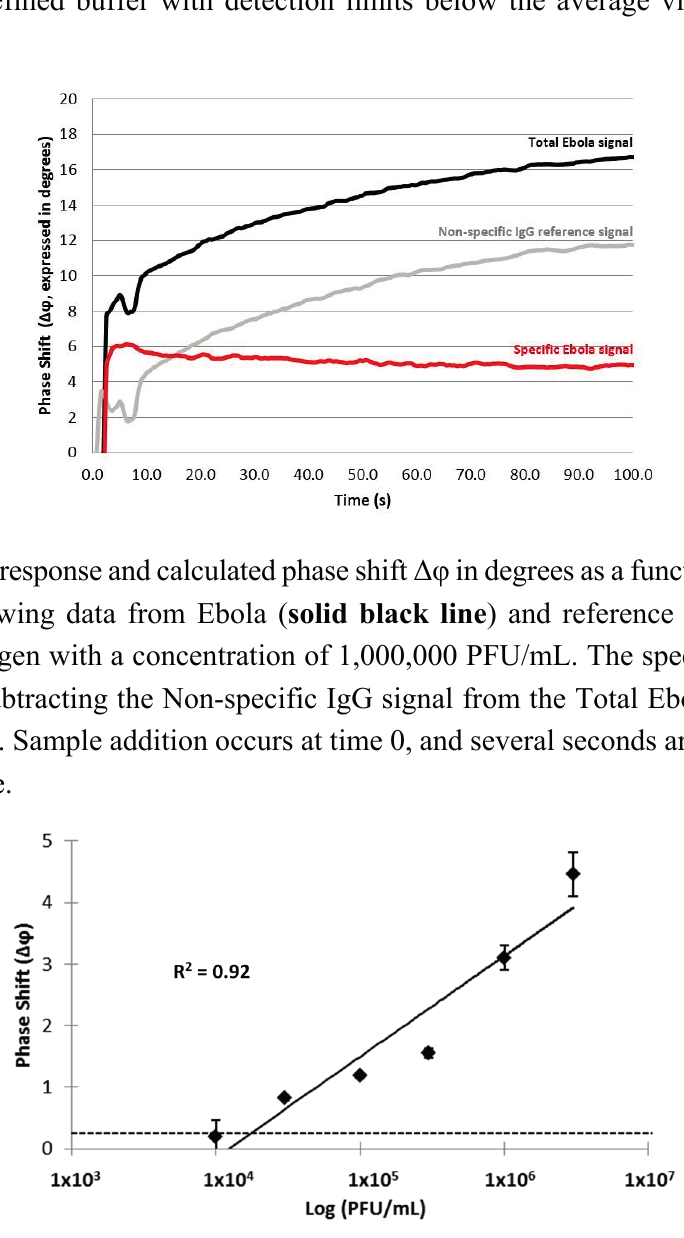
Figure 4. Detection of Ebola-Zaire with a SAW biosensor functionalized with an anti-Ebola monoclonal antibody. Triplicate measurements (mean ± standard deviation) were taken at 5 min after addition of the virus. Standard deviations for three of the data points are smaller than the corresponding size of the data marker. The x-axis and y-axis indicate viral load (logarithmic scale; PFU/mL) and phase shifts ( Δφ , expressed in degrees), respectively. Concentrations of Ebola antigen corresponding to PFU of intact virus were established in a defined buffer (PBS). The solid line represents a linear fit and the correlation coefficient ( R 2 ) of 0.92 suggests operation in a linear range. The horizontal dotted line represents the background signal obtained with buffer without virus, and is the basis for LOD